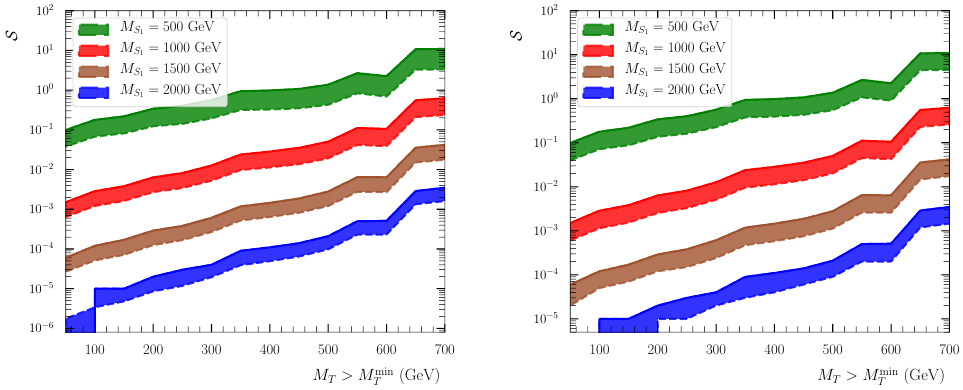
Figure 25 . Signal significance as a function of the cut on M T for ∆ X = 0 . 5 (left) and 0 . 1 (right), for M S = 500 GeV (green), 1 TeV (red), 1 . 5 TeV (brown), and 2 TeV (blue), and for M χ 1 We present results for a 2% (solid) and 5% (dashed) systematical uncertainty on the background.